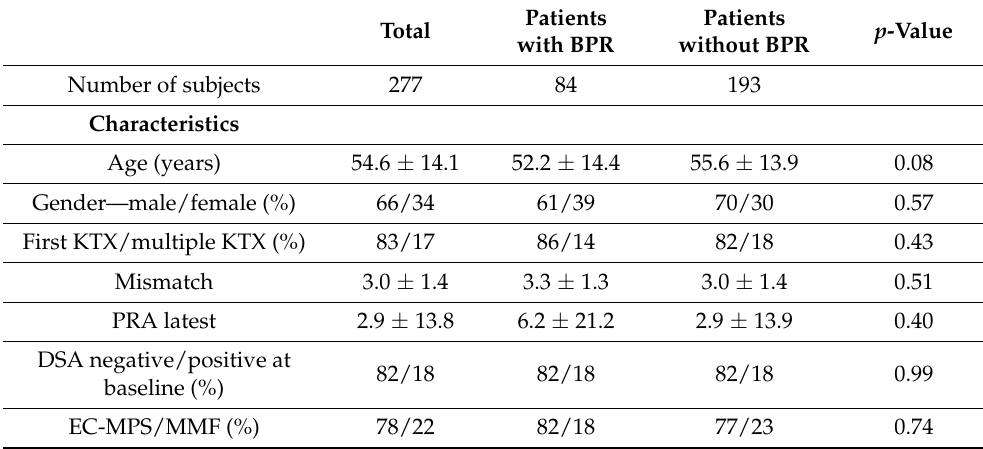
Table 1. Baseline characteristics of Study Patients.